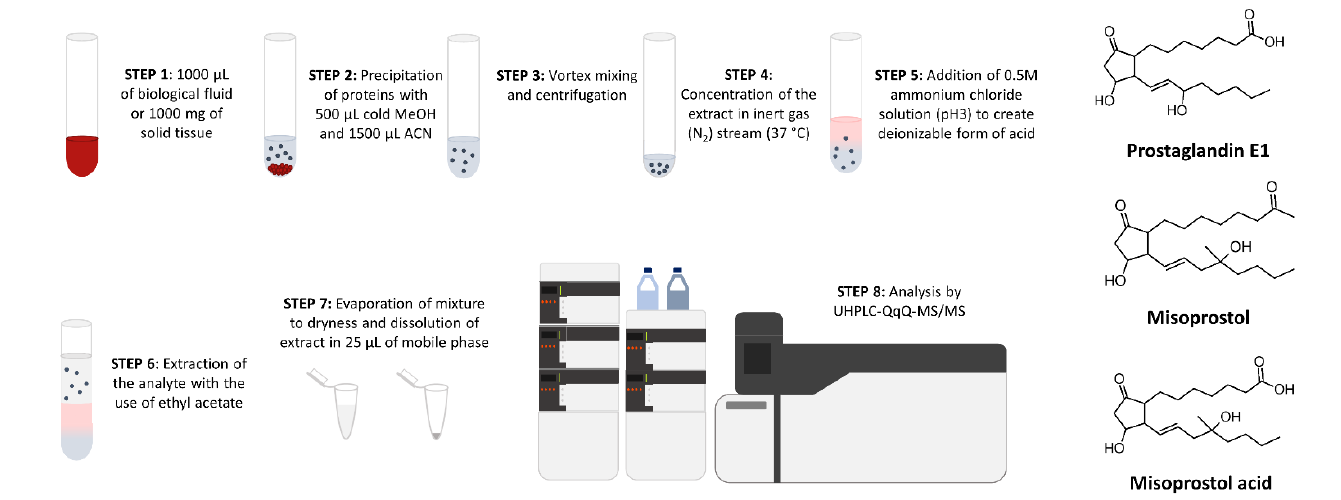
Figure 1. Scheme of biological samples preparation and analysis by developed UHPLC-QqQ-MS/MS as well as chemical structures of prostaglandin E1, misoprostol (synthetic PGE1 analogue) and its main metabolite–misoprostol acid.